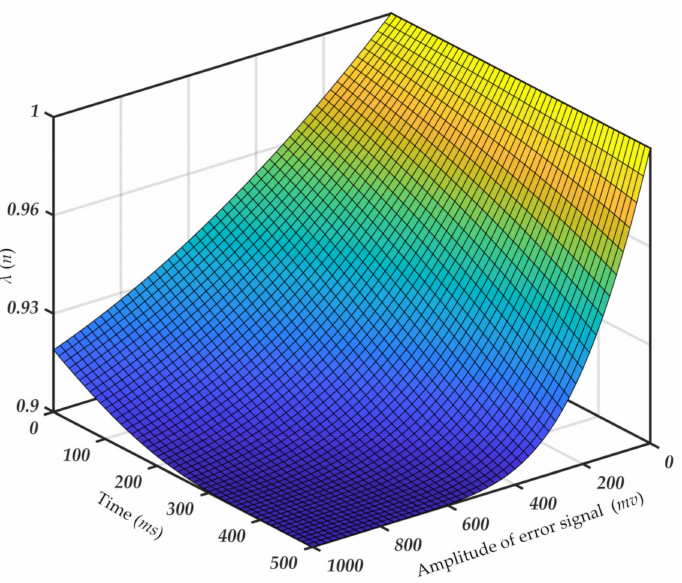
Figure 2. Relation between forgetting, time, and amplitude of the error